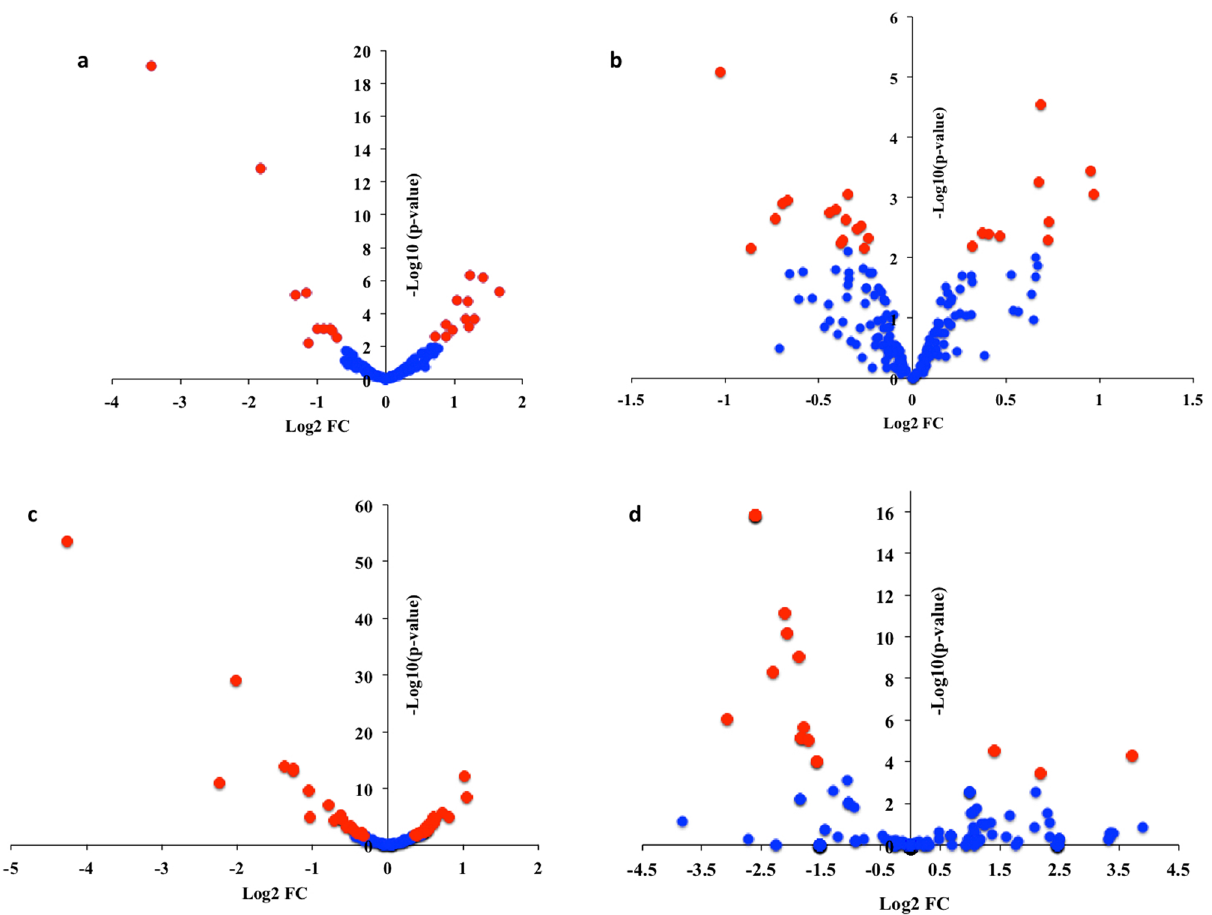
Figure 4. Differential expression analysis of miRNAs ( A ), piRNA clusters ( B ), lincRNAs ( C ), and snRNAs (D) in F 1 generation of embryos (5.5 hpf) from parents exposed to 8.7 mGy/h γ-radiation (F 1 -γ) and non-exposed control parents (F 1 -C). Differentially expressed genes are represented as red dots. Expression values are shown as log2 of fold changes (X-axis). Y-axis represents the negative log10 of the p values (n =